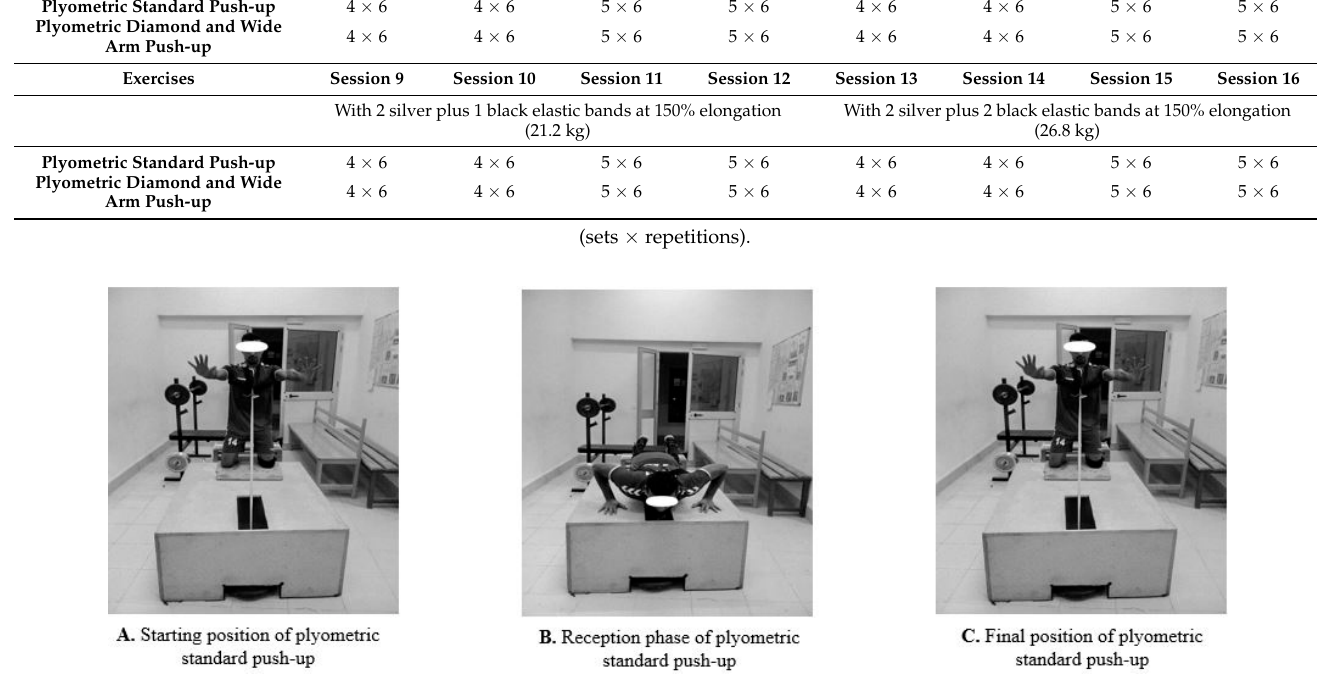
Figure 1. Phases of plyometric standard training exercise.